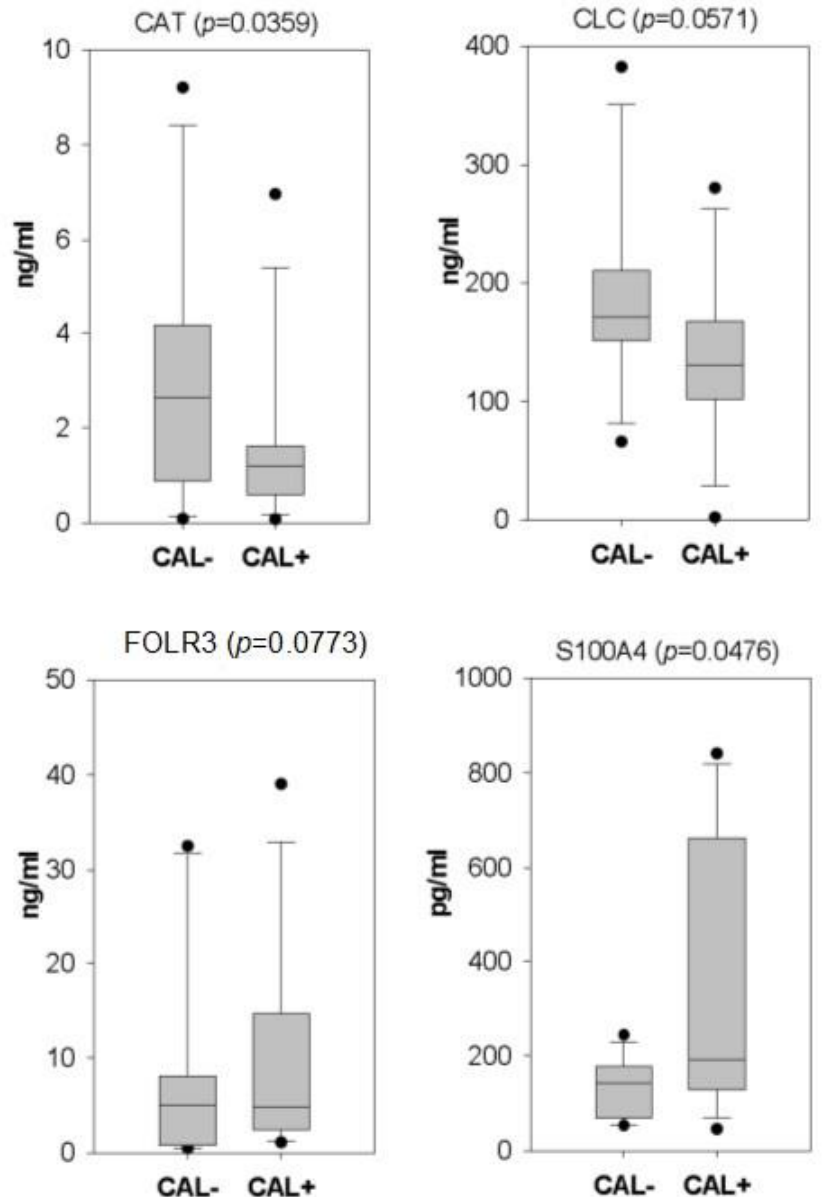
Figure 2. Box plots illustrate the ELISA validation results of four candidate CAL biomarker proteins. Following iTRAQ assay, four candidate serum proteins were validated with ELISA on all serum samples. With statistical significance, CAT and S100A4 kept higher levels in CAL-KD and CAL+KD samples, respectively. CAT—catalase; CLC—galectin 10; FOLR3—Folate receptor gamma;